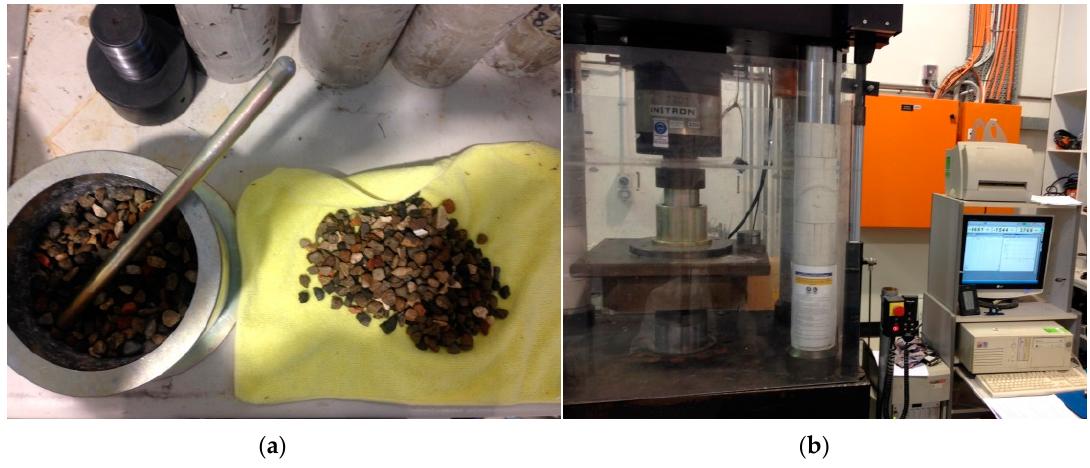
Figure 8. Conducting the Wet/Dry Strength Variation Test on Coarse Aggregate. ( a ) apparatus to crush aggregate; ( b ) compression machine.